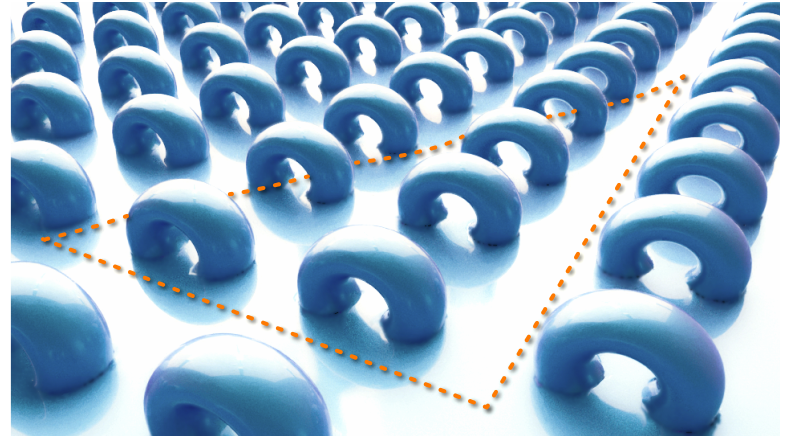
Figure 4: We can get complete 2-manifolds with constant negative sectional curvature by periodically attaching handles to the flat plane. Nevertheless, this space is not δ -hyperbolic since it coarsely looks like the plane and the typical geodesic triangles are nearly Euclidean.